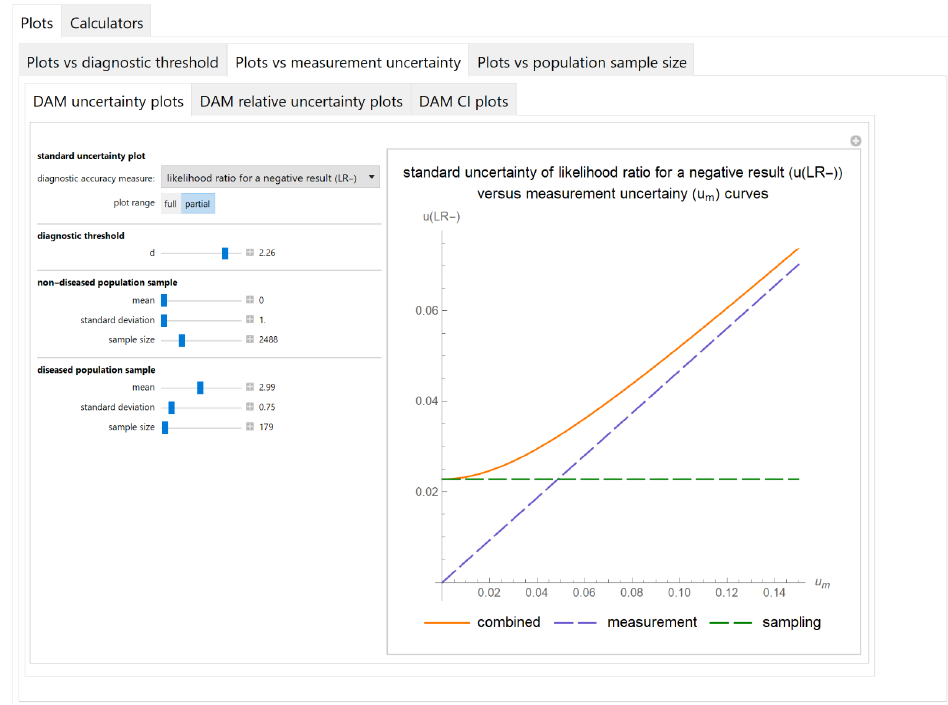
Figure 6. Plots vs. measurement uncertainty module, DAM uncertainty plots submodule screenshot. Standard combined, measurement and sampling uncertainty of likelihood ratio for a negative test result ( u(LR -) ) versus standard measurement uncertainty ( u m ) curve plot, with the settings shown on the left. The respective parameter settings are also shown in Table 3. Diagnostics 2021 , 11 , 406 Diagnostic Accuracy Measures Relative Standard Uncertainties Plots Submodule The values of the relative standard combined, measurement and sampling uncertain- ties of diagnostic accuracy measures of a screening or diagnostic test are plotted versus the measurement uncertainty of the test (Figure 7).